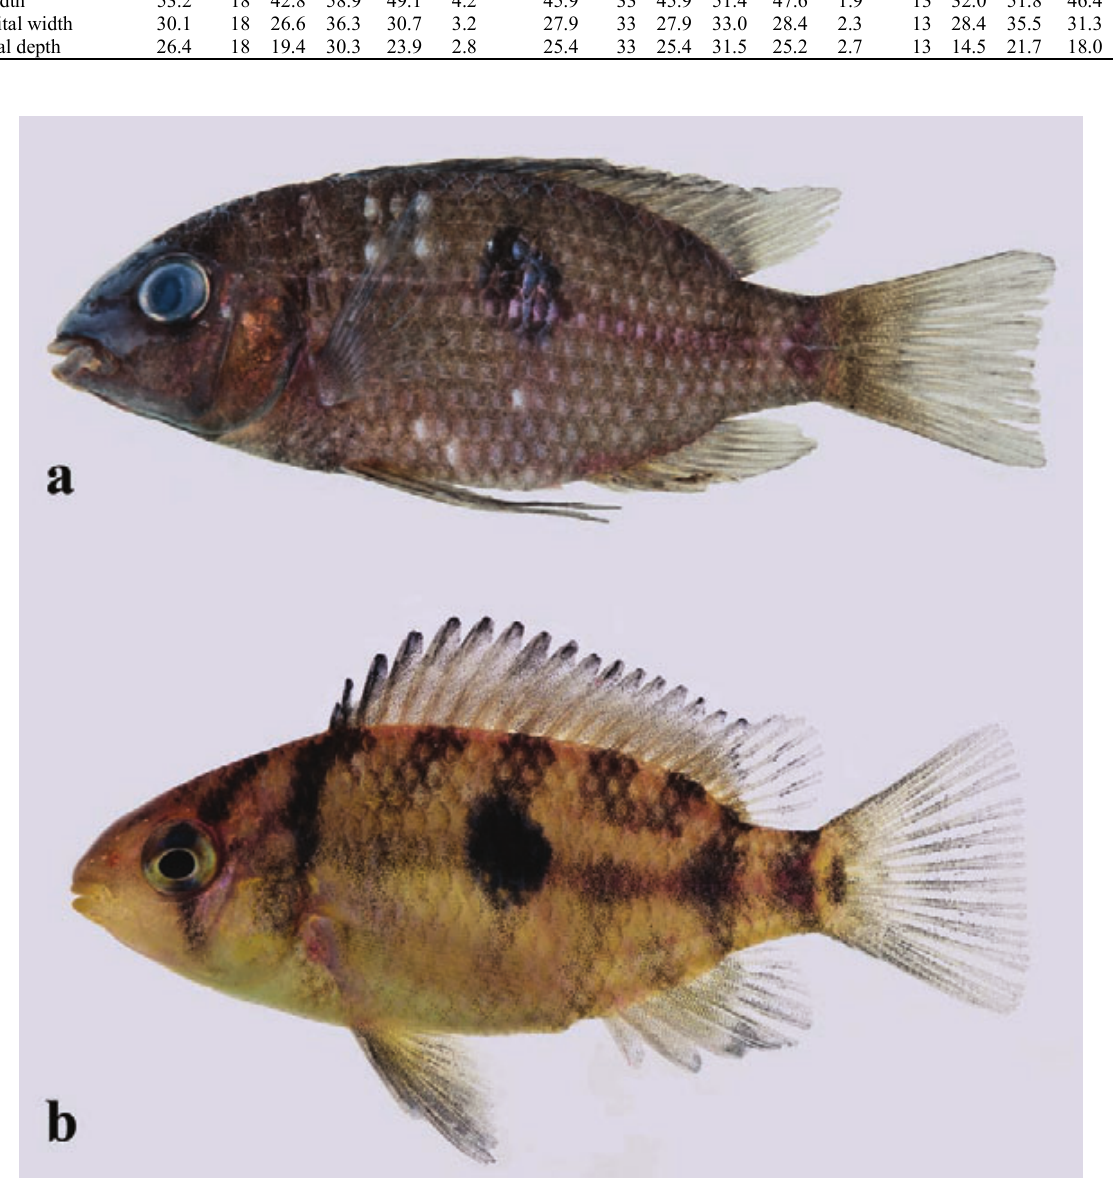
Fig. 4. Live colors of Mazarunia mazarunii through ontogeny; a ) adult individual, probably male, 76.7 mm SL, ROM 89531 shortly after capture and anesthetized with clove oil, b ) juvenile 38.1 mm SL, ROM 89609 shortly after